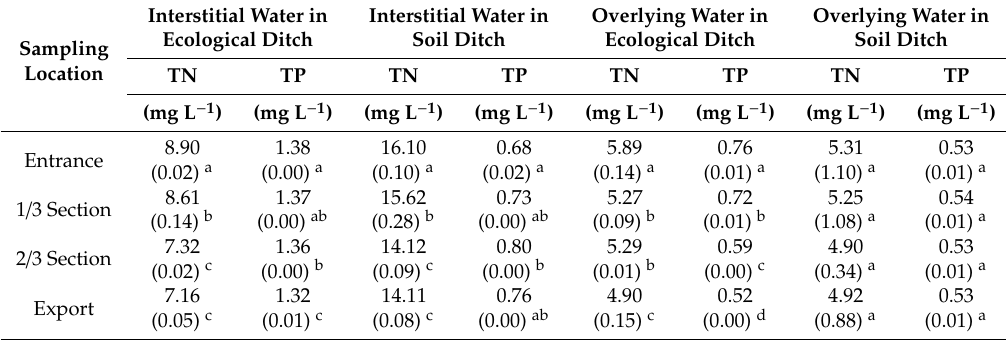
( C ) Figure 9. SEM images of zeolite dam matrix at different magnifications: X 500 ( A ); X 2000 ( B ); X 10000 ( C ).